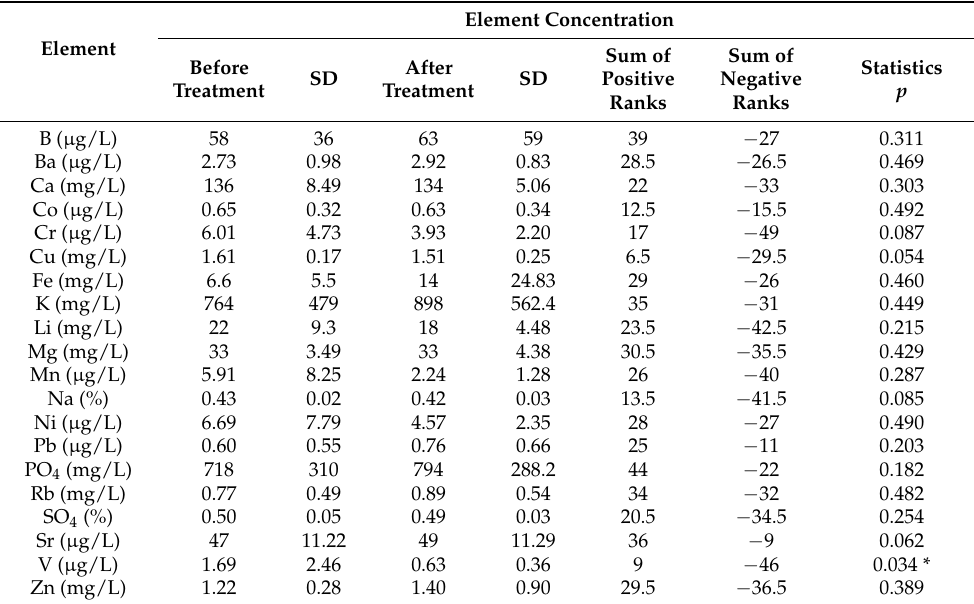
Element Concentration